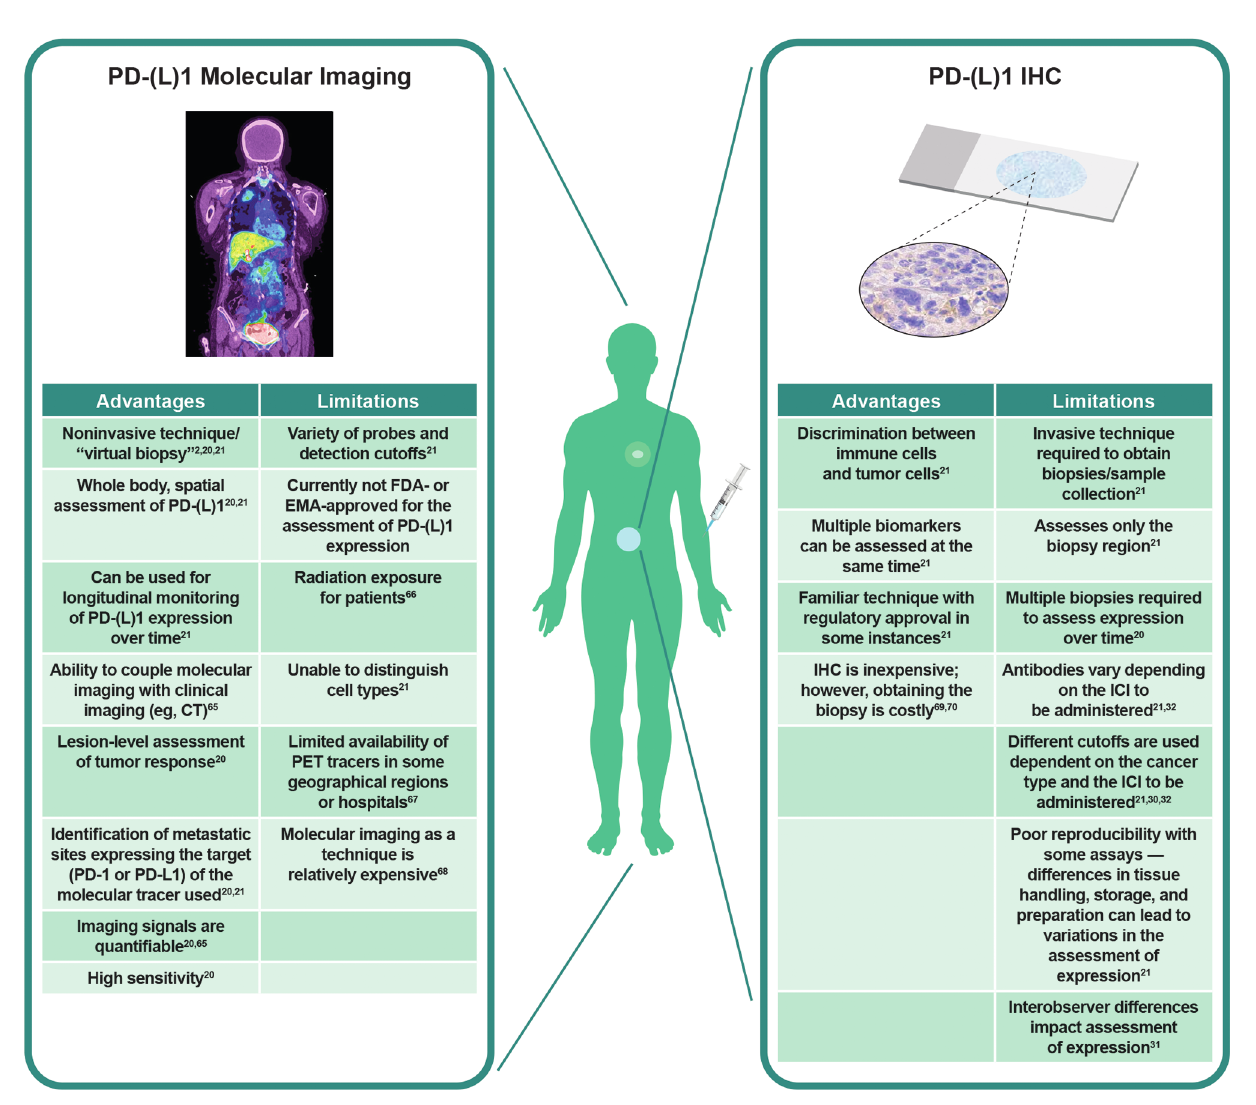
FIGURE 1 | Visualization of PD-L1 expression at tumor sites. Left panel: PD-L1 PET tracers can be used to visualize and monitor PD-L1 expression at all tumor sites. Right panel: IHC can be used to assess PD-L1 expression at the biopsy site, representing a small region of only one tumor. Adapted from Du et al. (2) and Broos et al. (21). CT, computed tomography; EMA, European Medicines Agency; FDA, Food and Drug Administration; ICI, immune checkpoint inhibitor; IHC, immunohistochemistry; PD-1, programmed death-1; PD-L1, programmed death ligand 1; PET, positron emission